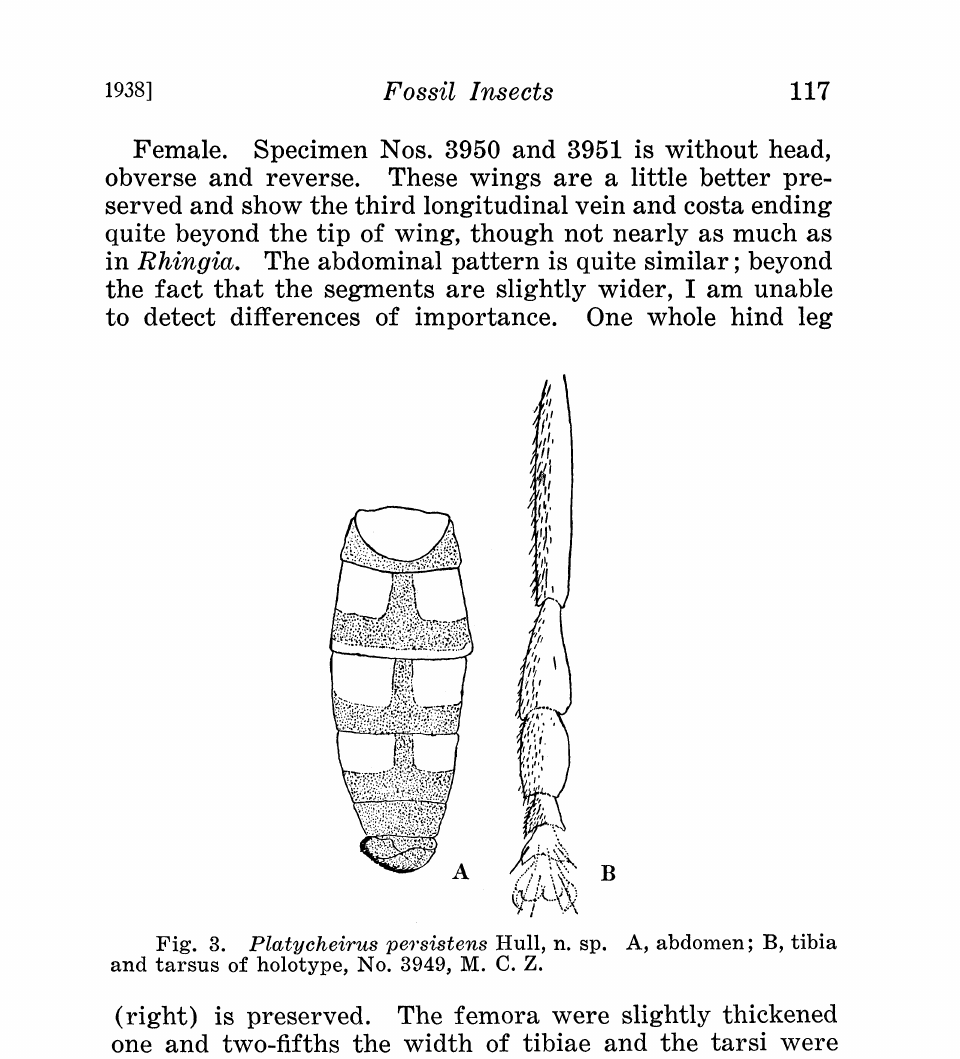
Fig. 3. Platycheiru.s persistens Hull, n. sp. A, abdomen; B, tibia and tarsus of holotype, No. 3949, M. C. Z. (right) is